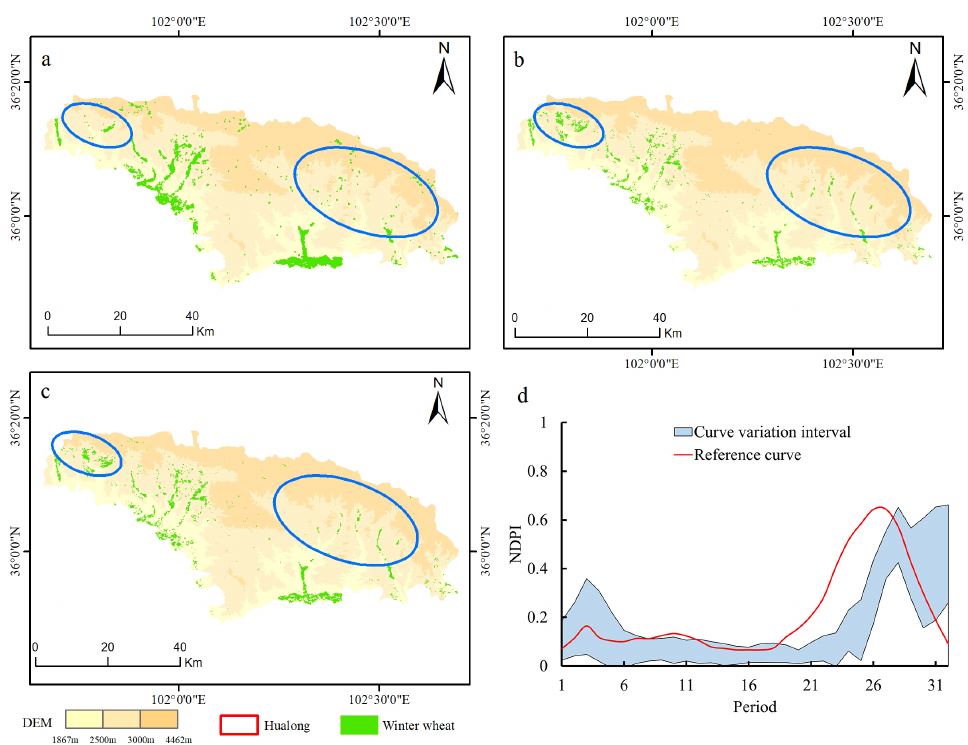
Figure 12. Extraction result of the study area. ( a ) Extraction results of Plan A ; ( b ) Extraction results of Plan B; ( c ) Extraction results of Plan C ; ( d ) Comparison of phenological